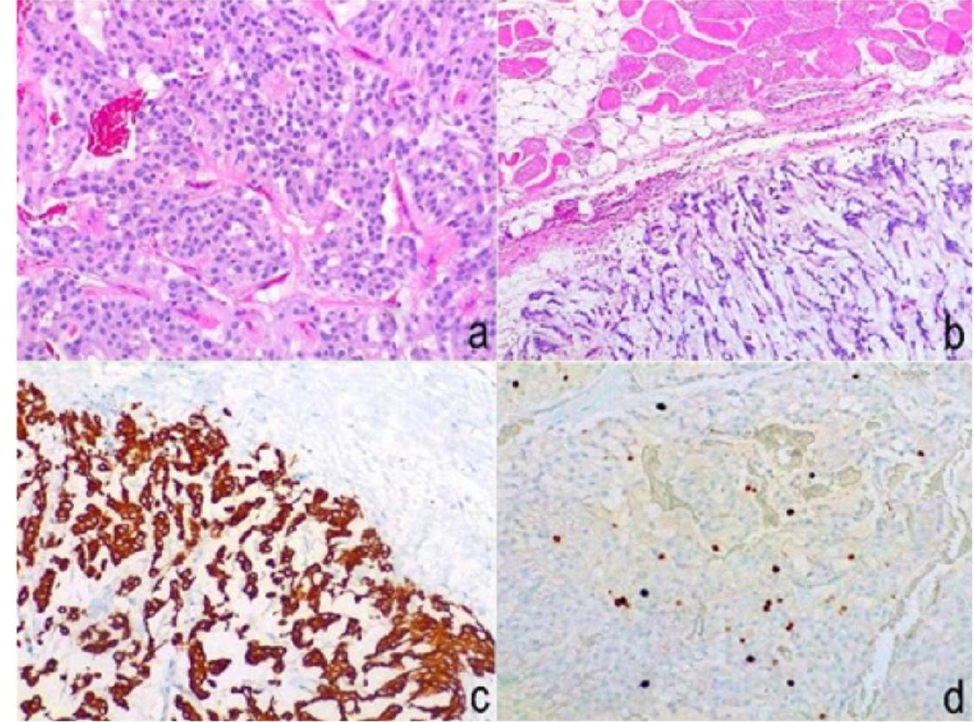
Figure 5. Histopathological images of lesion specimens. ( a ) (Hematoxylin and eosin stain, 200 ×): the solid component was composed of pseudopapillary structures made of cells with mild cytological atypia, separated by vascular space; ( b ) (hematoxylin and eosin stain, 100 ×) another component was made by epithelioid cells interspersed within mucoid material and in strict contact with fat tissue and striated muscular fibers; ( c ) neoplastic cells were immunoreactive to GFAP (100 ×), and ( d ) showed a low (<10%) cellular Ki67 proliferation index (100 ×).